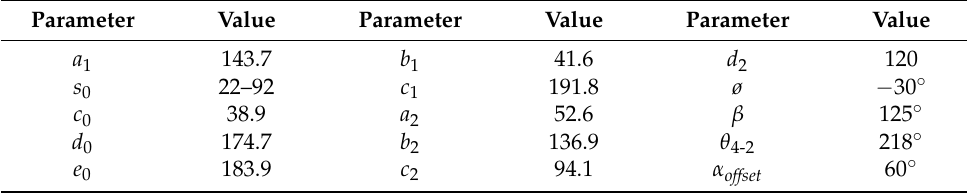
Table 3. Resultant construction